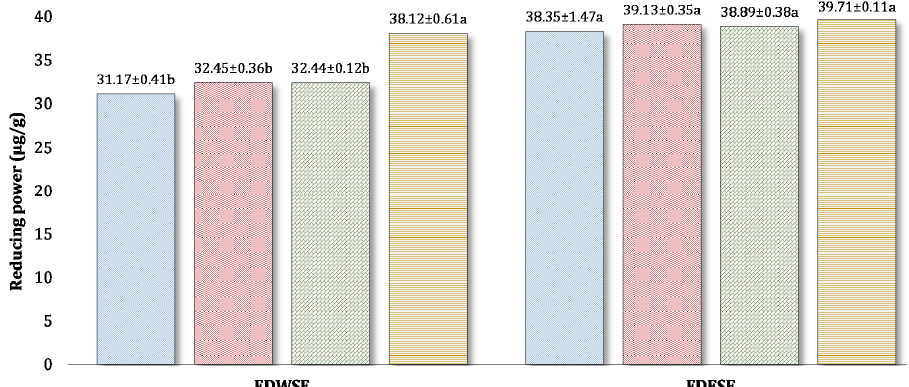
Figure 6. Mean values for Reducing power (RP) (µg/g Trolox equivalent) of freeze-dried water-soluble and ethanol-soluble extract of processed Cheddar cheese made from buffalo milk after ripening. a-b means followed by the same letter for each type of processed Cheddar cheese are not significantly different ( p <